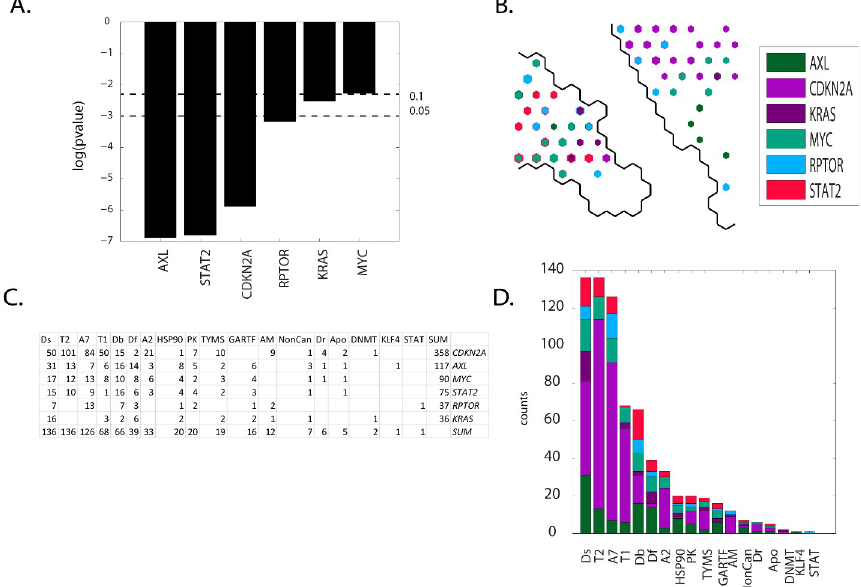
Fig 14. Results for group F(meta-clades 21 through 24). The SOM DTP region displayed in Panel B represents the boundary for meta-clades 21 through 24 (see the white border in Fig 8 Panel A ). S11 master_appendix sheet gp_F lists the table in Panel C. See legend to Fig 9 for additional details. S18 master_appendix sheet gp_F_FDA lists the FDA compounds associated with these defective